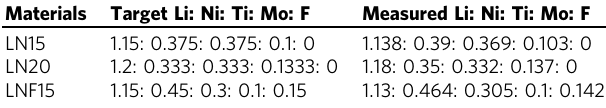
Table 1 Target vs. measured Li: Ni: Ti: Mo: F atomic ratio